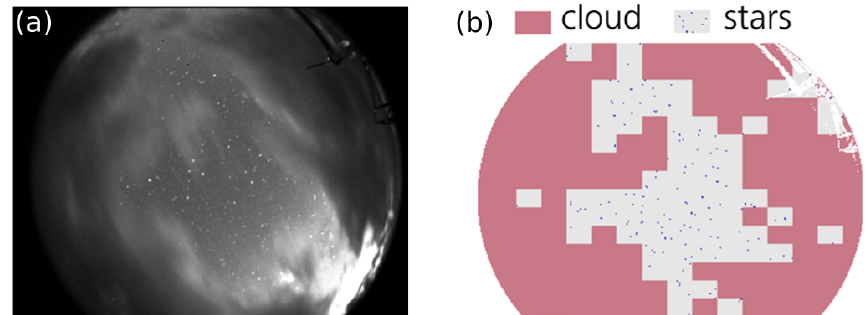
Figure 10. (a) Image acquired by the cloud monitoring camera and (b) detected stars. Image by N.